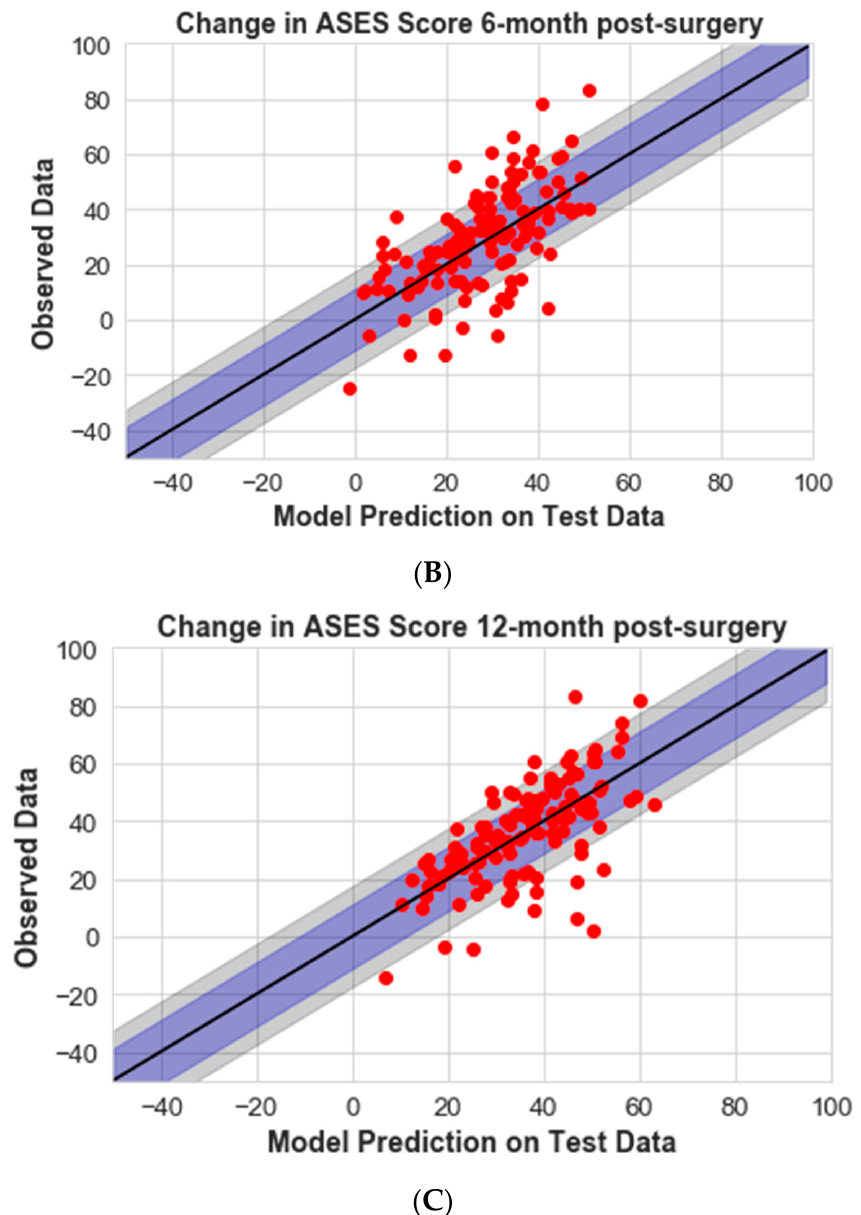
Figure 3. Parity plot of observed and predicted change in ASES score for 3- ( A ), 6- ( B ), and 12-month ( C ) post-operative follow-up relative to the pre-operative ASES score for the test dataset. The shaded blue region is the MCID, and the shaded grey region is the SCB.